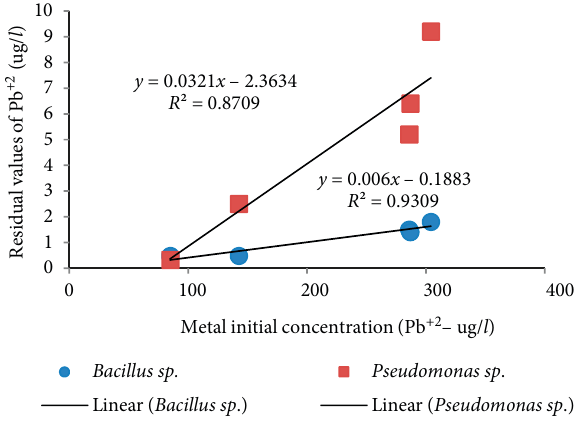
Fig. 1. Relationship between the initial concentration and